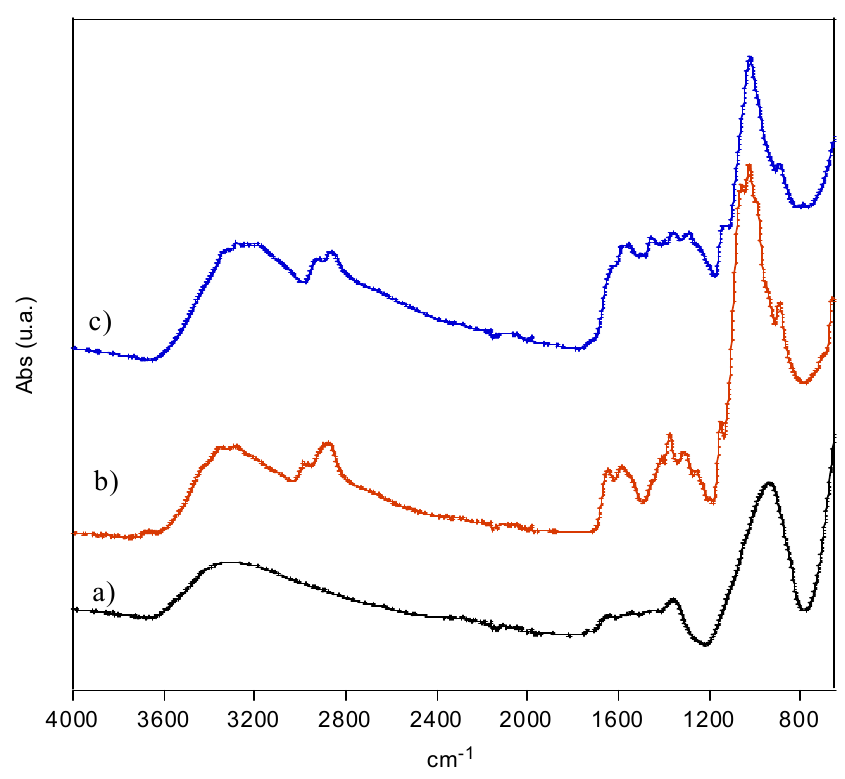
Figure 2. FTIR spectra of the naked MNPs ( a ), CS ( b ), and MNPs-CS nanocomposite ( c ). In the spectrum of the MNPs-CS nanocomposite (Figure 2c), the typical absorption bands of chitosan (Figure 2b) were clearly visible. Particularly, the peaks due to the –CH 2 stretching were observed in the range 2800–3000 cm − 1 , while the amide C=O stretching and the amide NH bending were present at 1650 cm − 1 and 1550 cm − 1 , respectively. Absorptions in the range 1480–1200 cm − 1 were attributed to the –CH 2 and –CH bending, and the wide peak at around 1050 cm − 1 was attributed to the –C–O–C stretching [23,24].